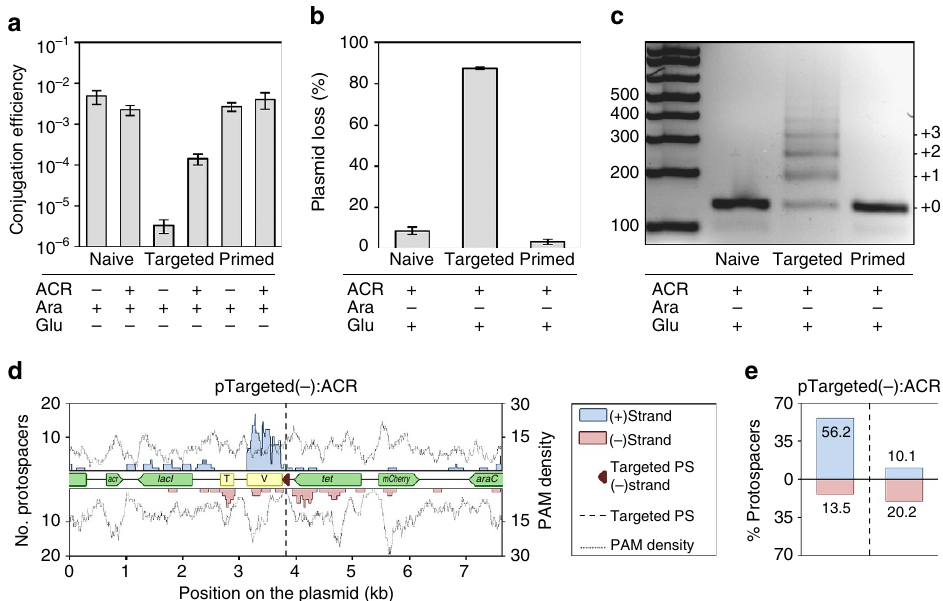
Figure 7 | Interference causes spacer acquisition. ( a ) Conjugation efficiencies of the control and anti-CRISPR containing vectors—pNaive:Control, pNaive:ACR, pTargeted( (cid:2) ):Control, pTargeted( (cid:2) ):ACR, pPriming( (cid:2) ):Control and pPriming( (cid:2) ):ACR—into wild-type P. atrosepticum in the presence of arabinose (Ara) to induce anti-CRISPR expression. ( b ) Plasmid loss for the transconjugants after 24h in non-selective media with repression of anti-CRISPR expression by glucose (Glu). Error bars represent the s.e. of the mean. ( c ) PCR of CRISPR1 from pooled culture of the samples in ( b ). ( d ) The protospacer locations of the spacers acquired in CRISPR1 were mapped on pTargeted( (cid:2) ):ACR using a sliding 150nt binning window. ( e ) Proportion of newly targeted protospacers 5 0 and 3 0 of the PPS on each strand. Labelling is the same as Fig.